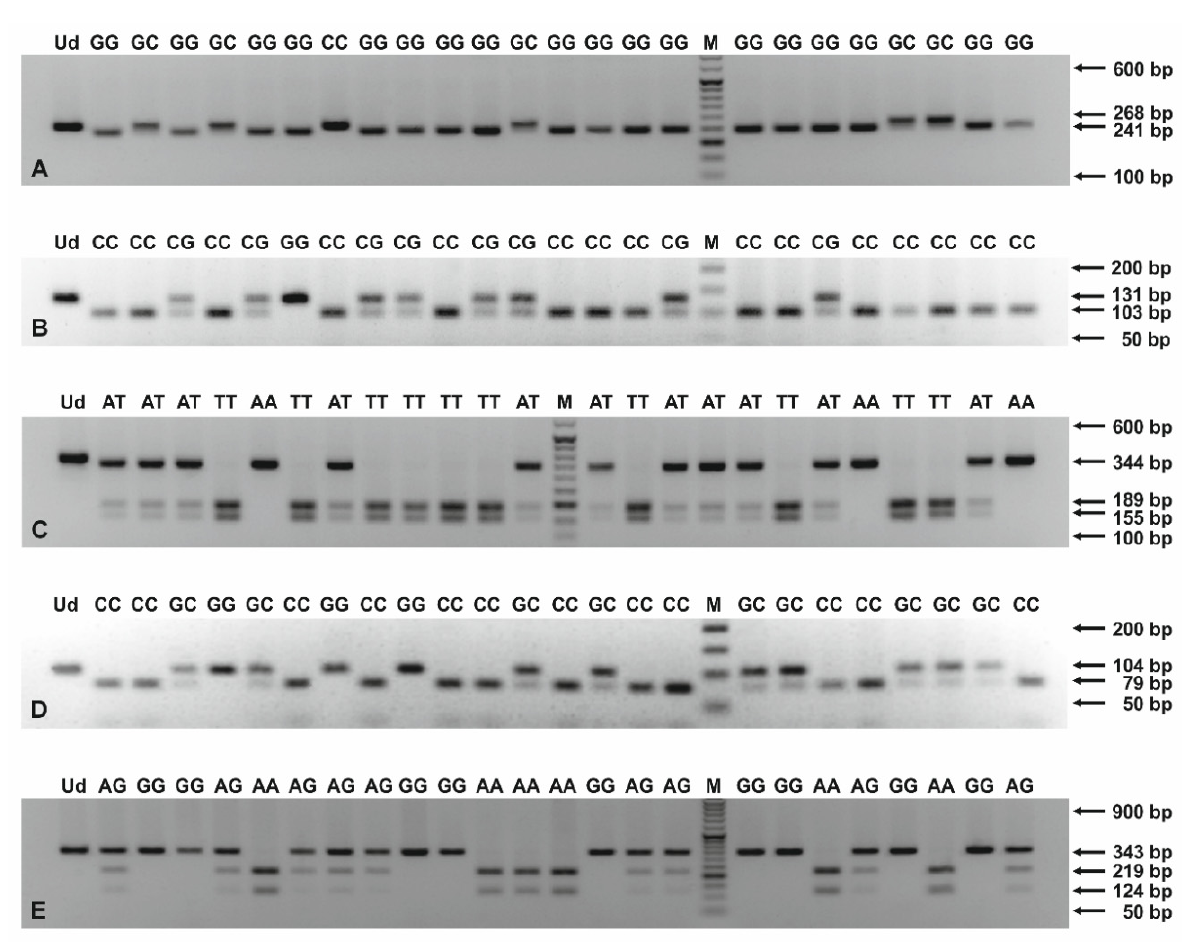
Figure 1. PCR-RFLP products for genotyping of ANGPT2 − 35 G > C ( A ), HLX rs2184658 ( B ), rs868058 ( C ), ITGAV rs3911238 ( D ), and rs3768777 ( E ) polymorphisms. The PCR products were digested with endonucleases: HindIII ( A ), MnlI ( B ), VspI ( C ), MvaI ( D ), and NlaIII ( E ), and then separated in 2.5–3.4% agarose gels, stained with ethidium bromide. The numbers to the right of the electropherograms show the lengths of separated DNA fragments. M: 50 bp DNA marker; Ud: undigested PCR product; AA, AG, AT, CC, CG, GC, GG, TT: genotypes in studied SNPs.